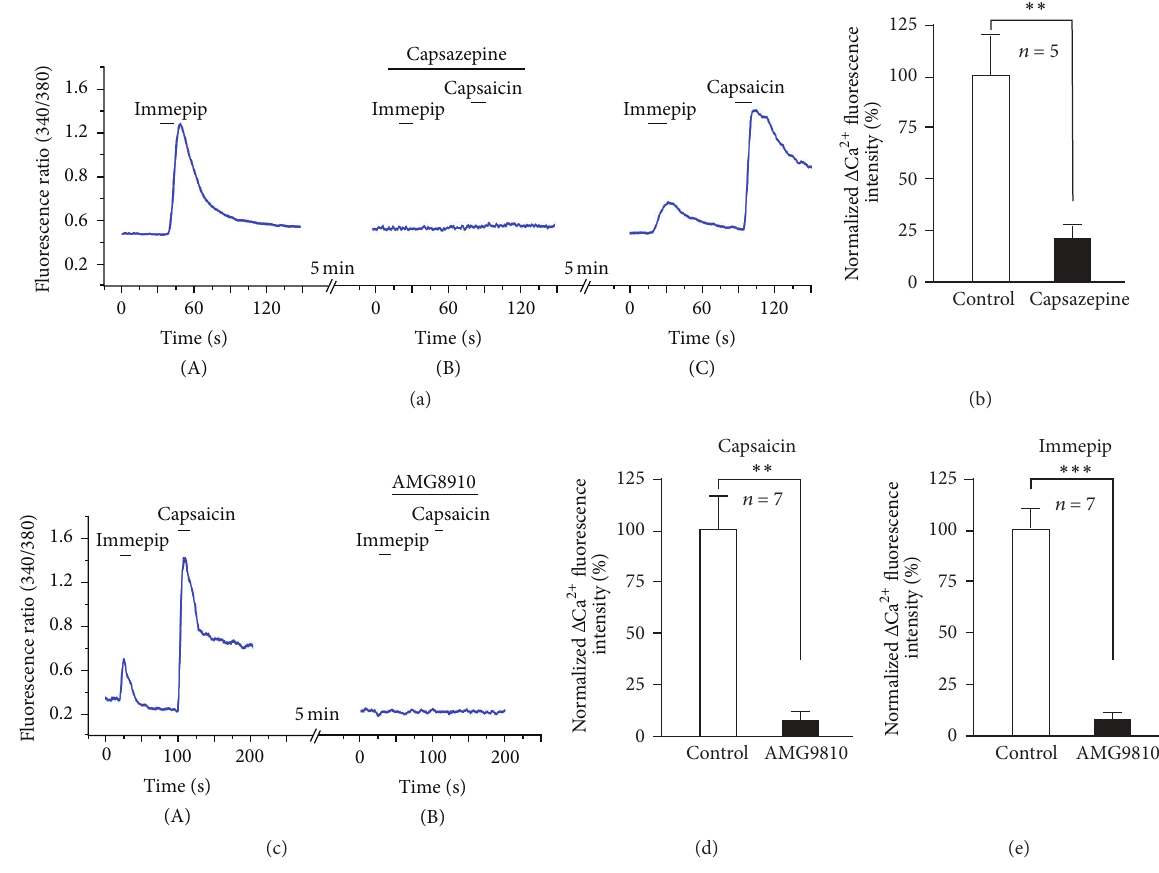
Figure 5: The effects of TRPV1 antagonist capsazepine on the immepip-induced increase in [ Ca 2+ ] i of DRG neurons. (a) H4 agonist immepip (50 𝜇 M) and TRPV1 agonist capsaicin (1 𝜇 M)-evoked increase in [ Ca 2+ ] i were evidently inhibited by TRPV1 antagonist capsazepine (1 𝜇 M) ( 𝑁 = 5 ), after washout of capsazepine, the DRG neuron recovery response to immepip and capsaicin. (c) Immepip (50 𝜇 M) and TRPV1 agonist capsaicin (1 𝜇 M)-evoked increase in [ Ca 2+ ] i were also obviously blocked by TRPV1 typical antagonist AMG9810 (5 𝜇 M) ( 𝑁 = 7 ).